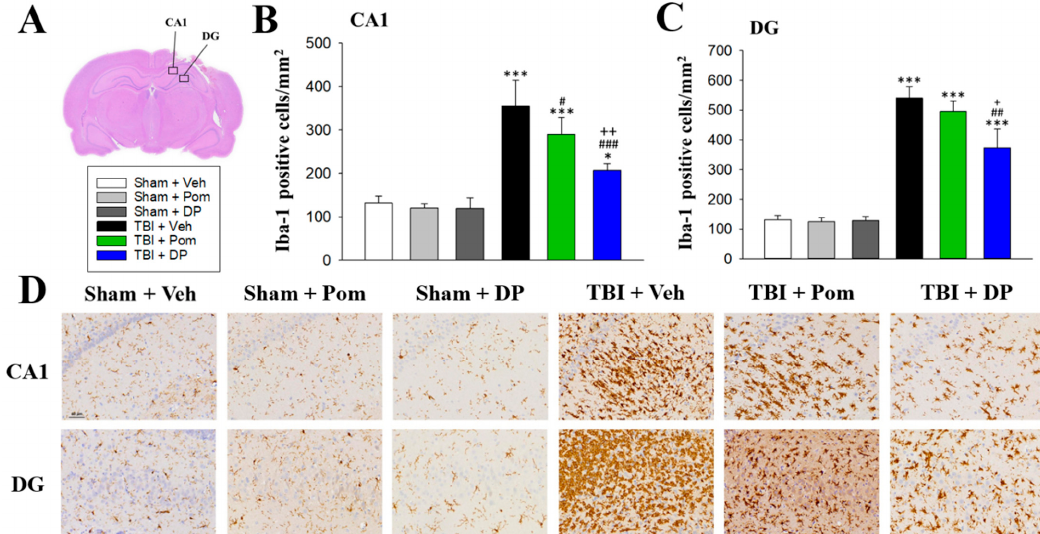
Figure 6. Only DP reduced the TBI-induced microgliosis in both hippocampus fields at 7D after a TBI. ( A ) Representative image of an HE-stained coronal brain section from TBI + Veh that shows the areas of evaluation at 7 days after a TBI. Quantitative comparison of mean densities of Iba-1-positive cells in the hippocampal CA1 ( B ) and DG ( C ) regions at 7 days after a TBI. ( D ) Representative photomicrographs showing the Iba-1-stained hippocampal CA1 and DG regions from various groups at 7 days after a TBI. Data are expressed as the mean ± S.E.M. * p < 0.05, *** p < 0.001 versus Sham + Veh group; # p < 0.05, ## p < 0.01, ### p < 0.001 versus TBI + Veh group; + p < 0.05, ++ p < 0.01 versus TBI + Pom group ( n = 5 in each group). Statistical differences were analyzed using independent sample t-tests and one-way ANOVA, followed by Tukey’s post hoc comparisons. Scale bar: 60 µ